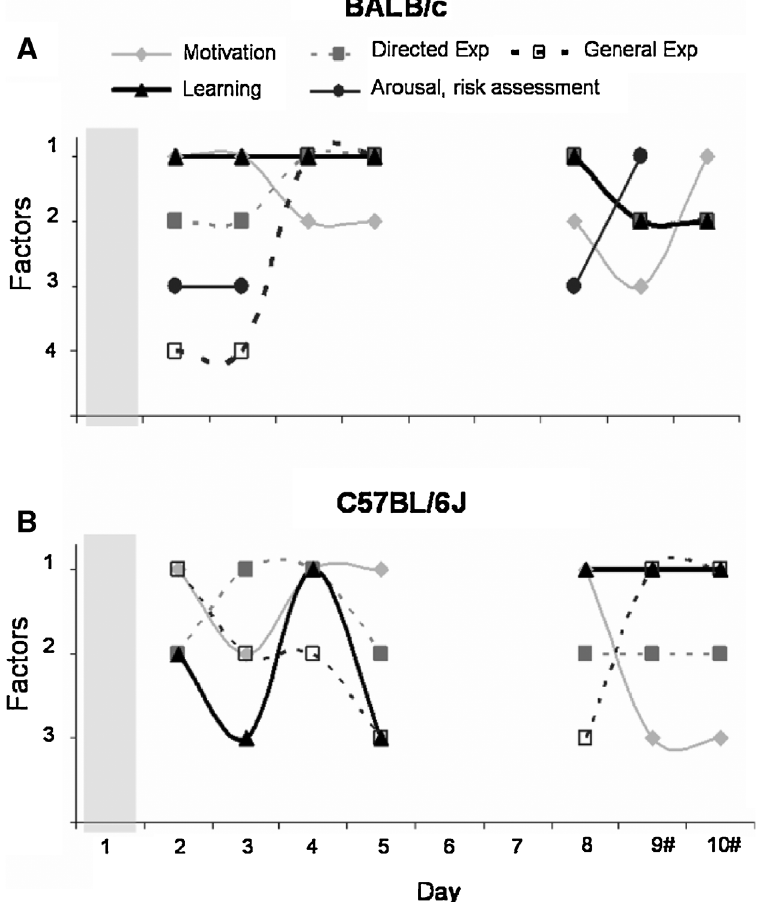
Figure 7. Distribution of behavioral classes per testing day in the extracted factors of the PCA. ( A) BALB/c mice and ( B) C57BL/6J mice. Symbols: Closed gray diamonds—motivation; open squares—general exploration; closed circles—emotion; closed squares—directed exploration; closed triangles—learning. # Baited cylinders were relocated on days 9 and 10